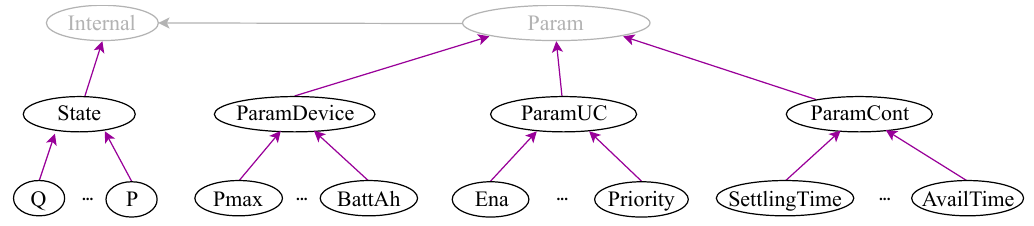
Figure 7. Graph representation of parameters and